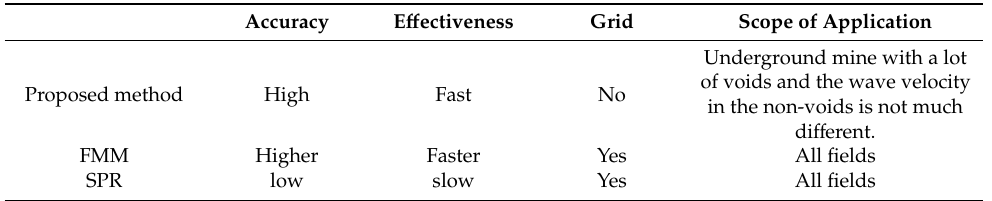
Table 3. Comparison of our proposed method, FMM, and SPR.